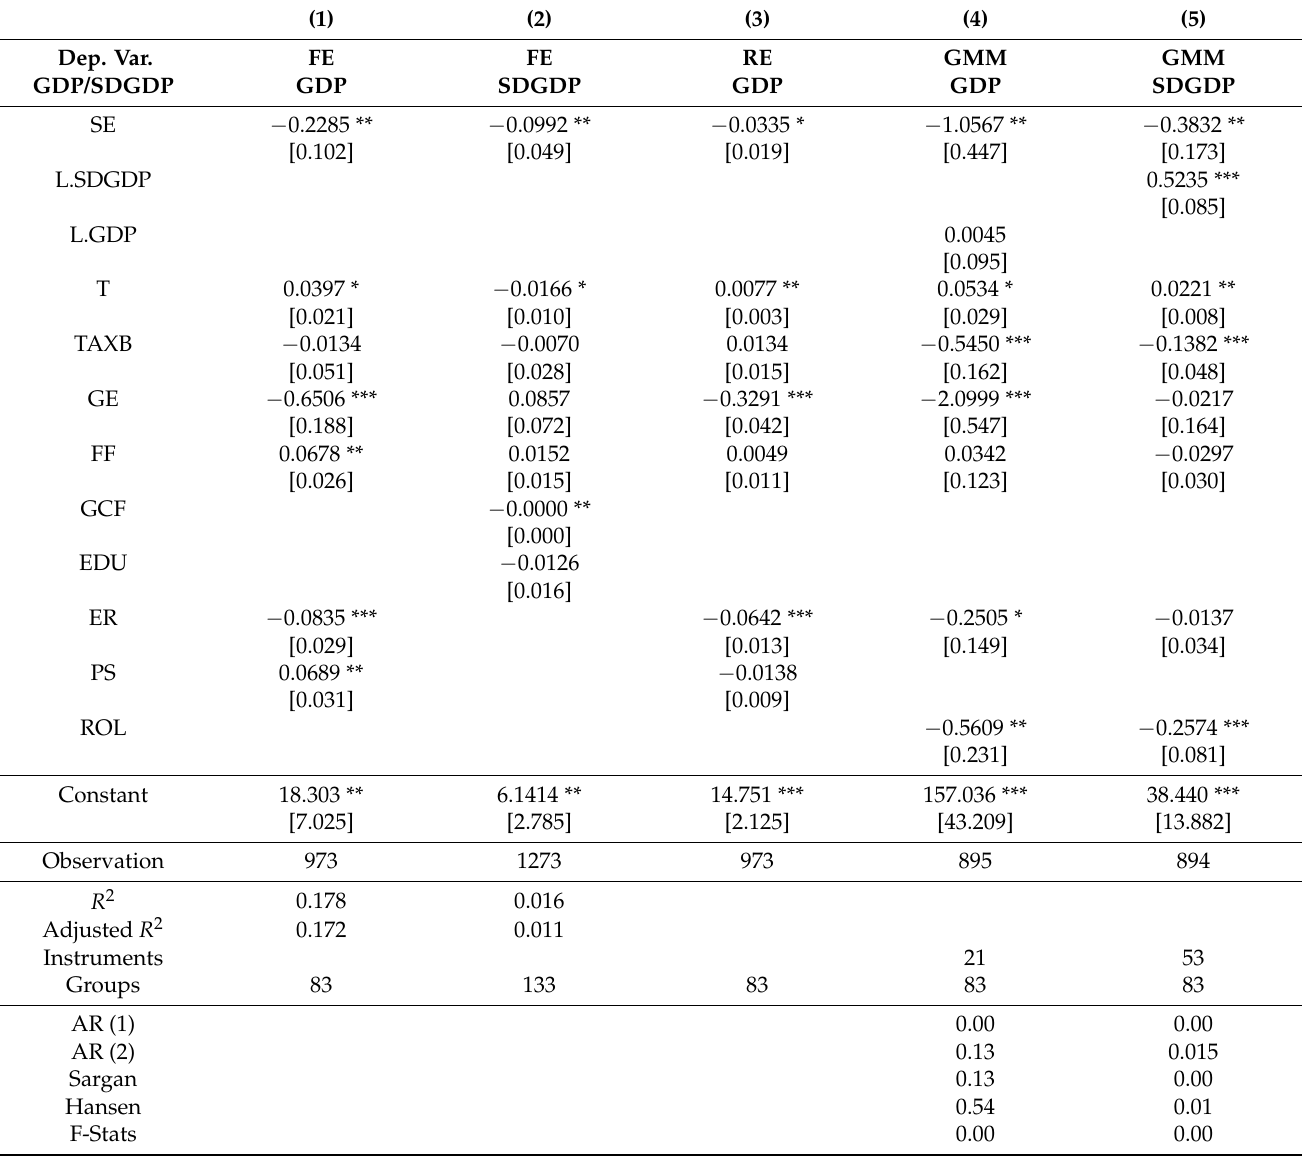
Table A2. Impact of shadow economy on economic stability (Alternative Variables and